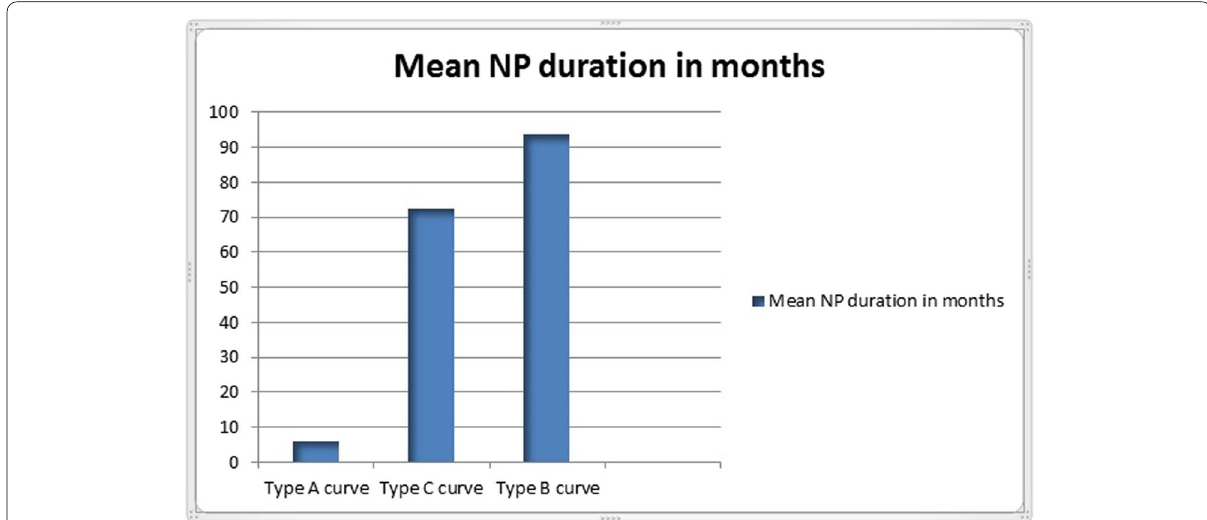
Fig. 1 The chart shows the relation between mean duration of the nasal polyposis and the tympanometric results